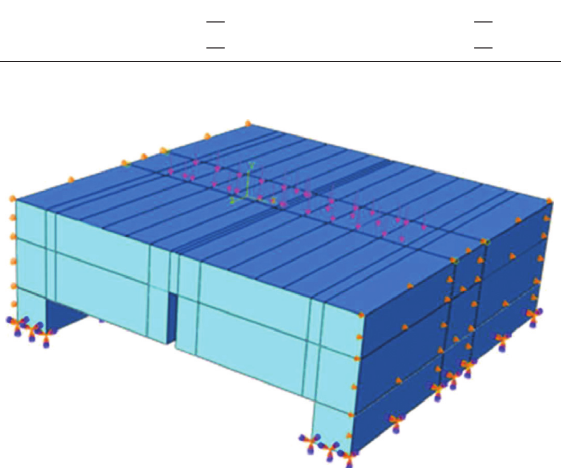
Figure 6: The moving load arrangement and boundary conditions of the XFEM-based